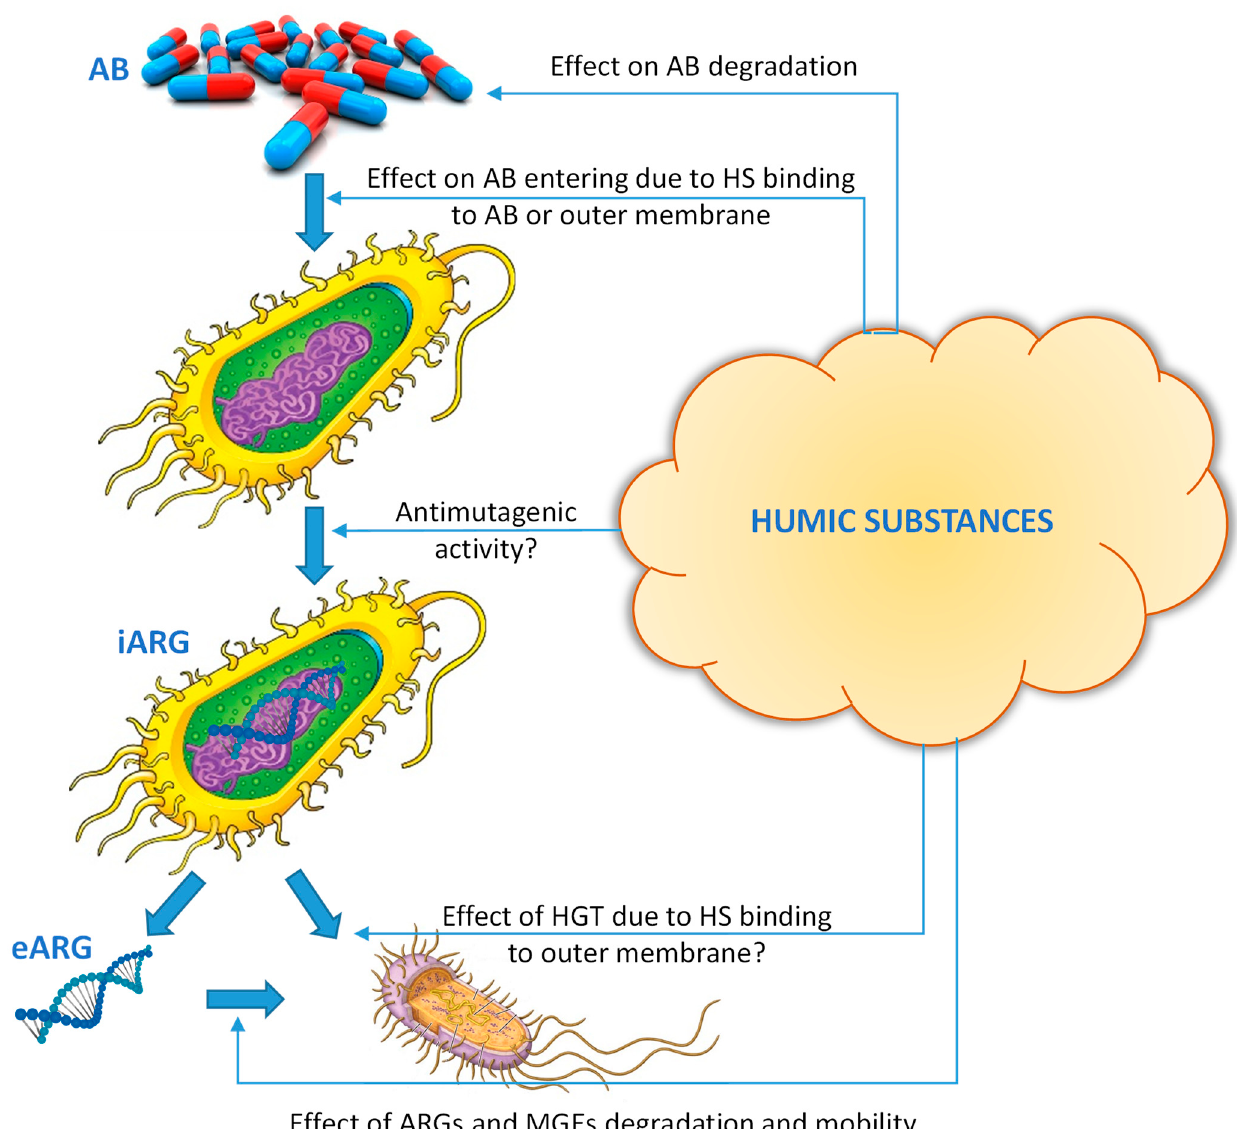
Figure 4. Putative ways of HS’ effect on ARG dissemination in the environment. AB—antibiotic; HS—humic substances; iARG—intracellular ARG; eARG—extracellular ARG; HGT—horizontal transfer; MGEs—mobile genetic elements.